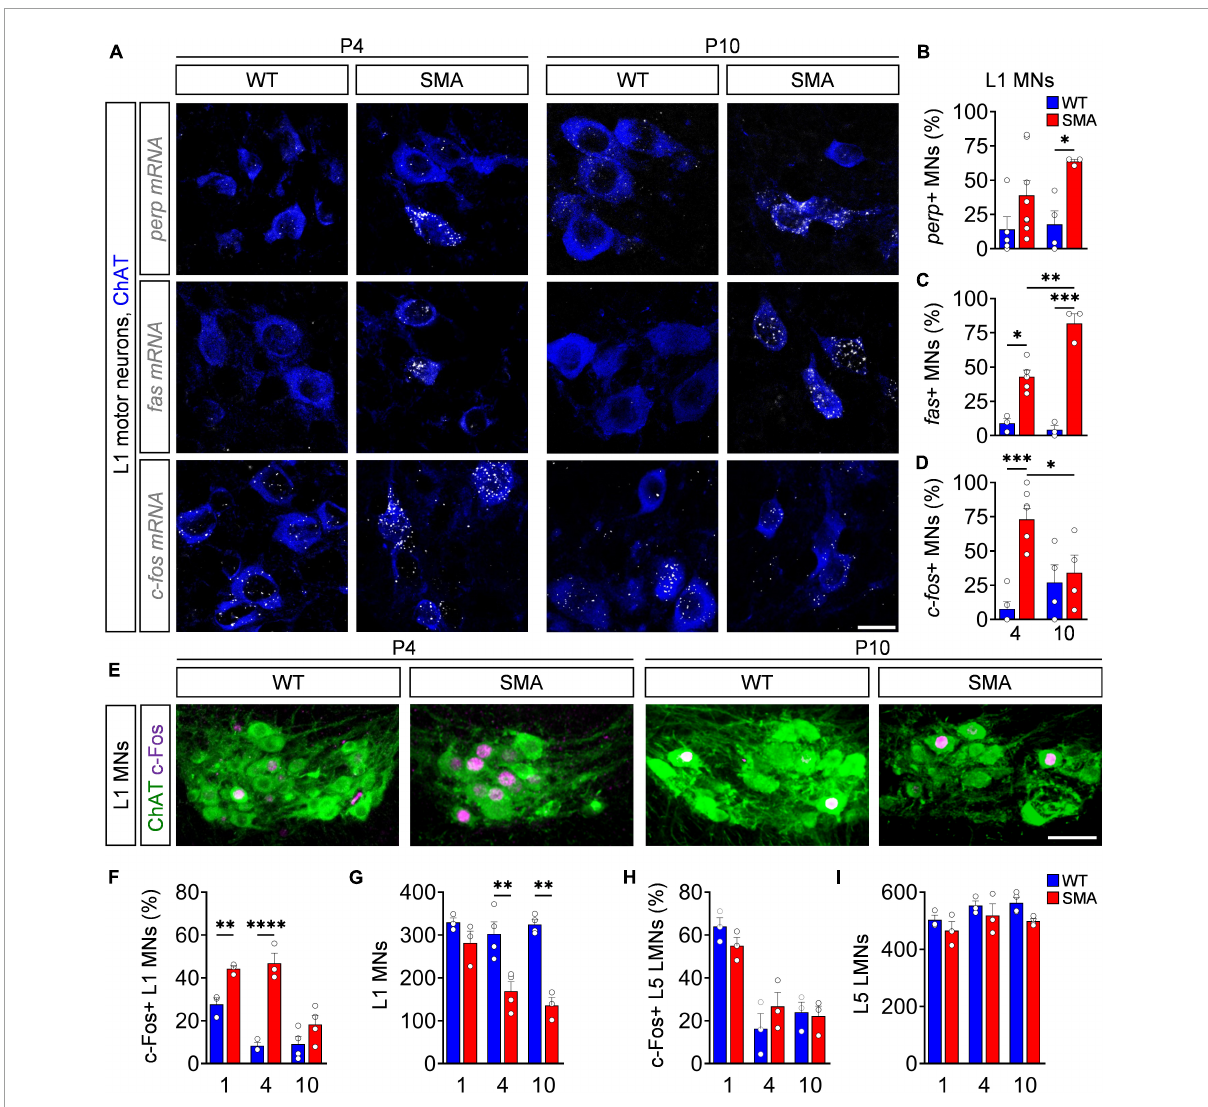
FIGURE1 c-Fos upregulation reliably marks motor neuron degeneration in a severe spinal muscular atrophy (SMA) mouse model. (A) Fluorescence in situ hybridization (FISH) analysis of perp , fas or c-fos mRNA (white) expression with ChAT (blue) immunostaining as a motor neuron (MN) marker of L1 spinal cord segment from P4 and P10 control wild-type (WT) and SMN (cid:49) 7 mutant (SMA) mice. Scale bar = 20 µ m. (B–D) Quantification of perp , fas , and c- fos mRNA positive MNs from the same groups as in panel (A) (for details see section “Fluorescence in situ hybridization”). n = 3–8 per genotype. For each animal 11–30 motor neurons were analyzed. (E) Immunostaining of c-Fos (magenta) and L1 ChAT + motor neurons (green) of spinal cords from the same groups as in panel (A) . Scale bar = 50 µ m. Quantification of c-Fos positive L1 MNs in percent (F) , number of L1 MNs (G) , c-Fos + L5 lateral motor neurons (LMNs) in percent (H) and number of L5 LMNs (I) . n = 3–4 per genotype. Statistics: two-way ANOVA with Tukey’s correction for panels (B,C,F–I) . Each data point (n) represents one animal. Data are presented as mean ± SEM. Asterisks on top of bars without horizontal line indicate the significance compared to another group. * p < 0.05; ** p < 0.01; *** p < 0.001, **** p <